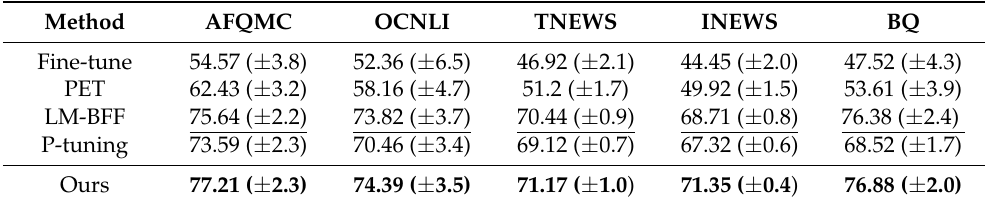
Table 3. Model performance. The result of the best performing baseline and the best performer in each column is underlined and boldfaced,